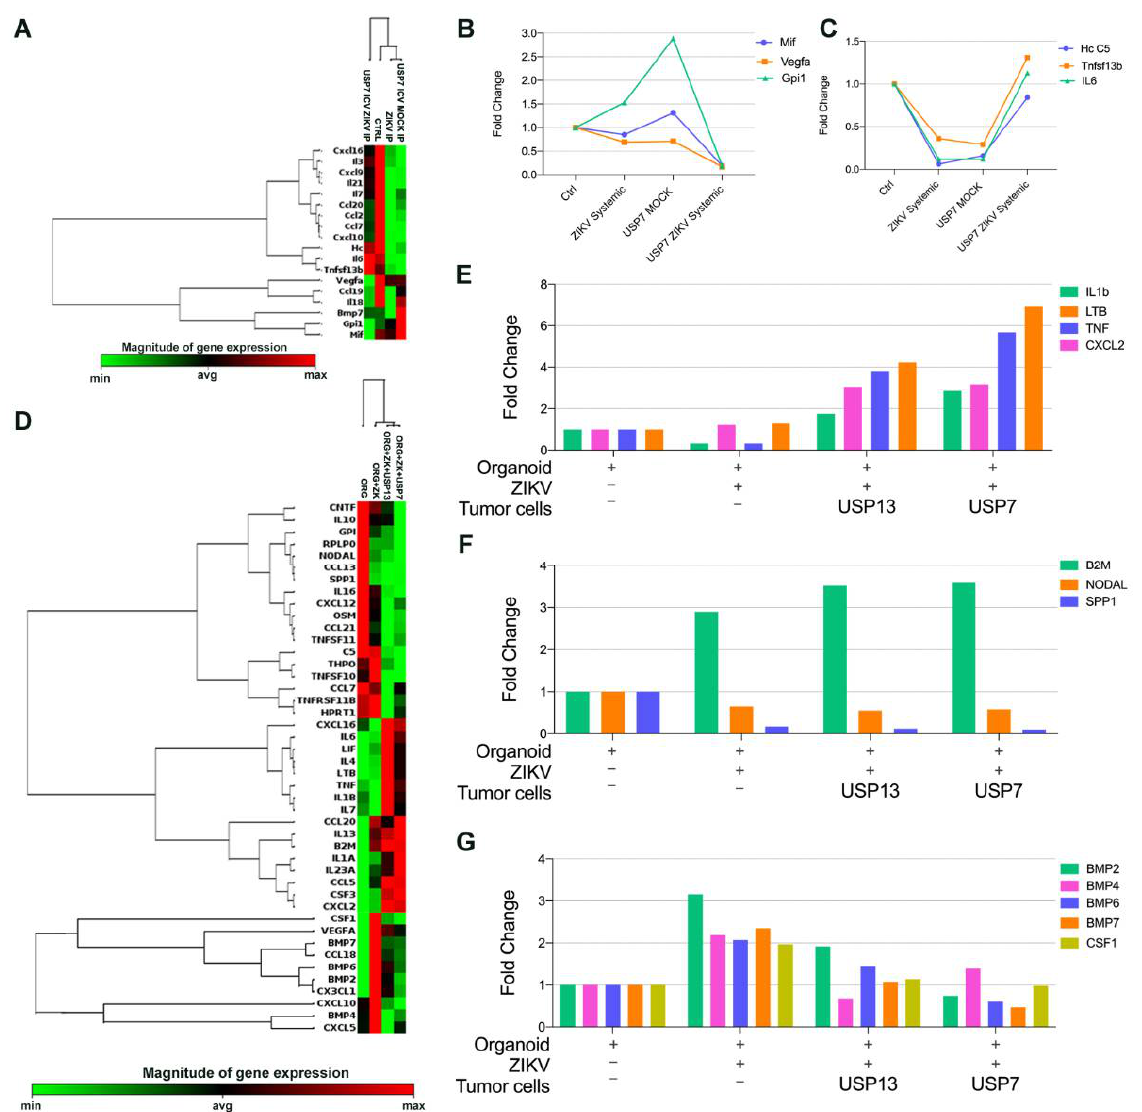
Figure 5. Comparative microarray gene expression of cytokine and chemokine from in vivo and 3D in vitro assay. ( A – C ) RT-PCR array analysis of mice brain bearing ATRT embryonal CNS tumor after three systemic ZIKV BR injections (2000 PFU). ( A ) Heatmap analysis of normalized gene expression values represented as colors, from green (low expression) to red (high expression). ( B , C ) Highlight of transcript expression considering transcripts downregulated ( B ) and upregulated ( C ) in mice bearing USP7ATRT tumor and treated with ZIKV BR in comparison with control, ZIKV BR , and MOCK groups. ( D – F ) RT-PCR array analysis of brain organoids co-cultured with/without embryonal CNS tumor cells after three 2000 PFU ZIKV BR administrations. ( D ) Heatmap analysis of normalized gene expression values represented as colors, from green (low expression) to red (high expression). ( E , F ) Highlight of transcript expression considering transcripts upregulated ( E ) in organoids co-culture with embryonal CNS tumor cells, up/downregulated in organoids after ZIKV BR infection, with and without embryonal CNS tumor cells ( F – G